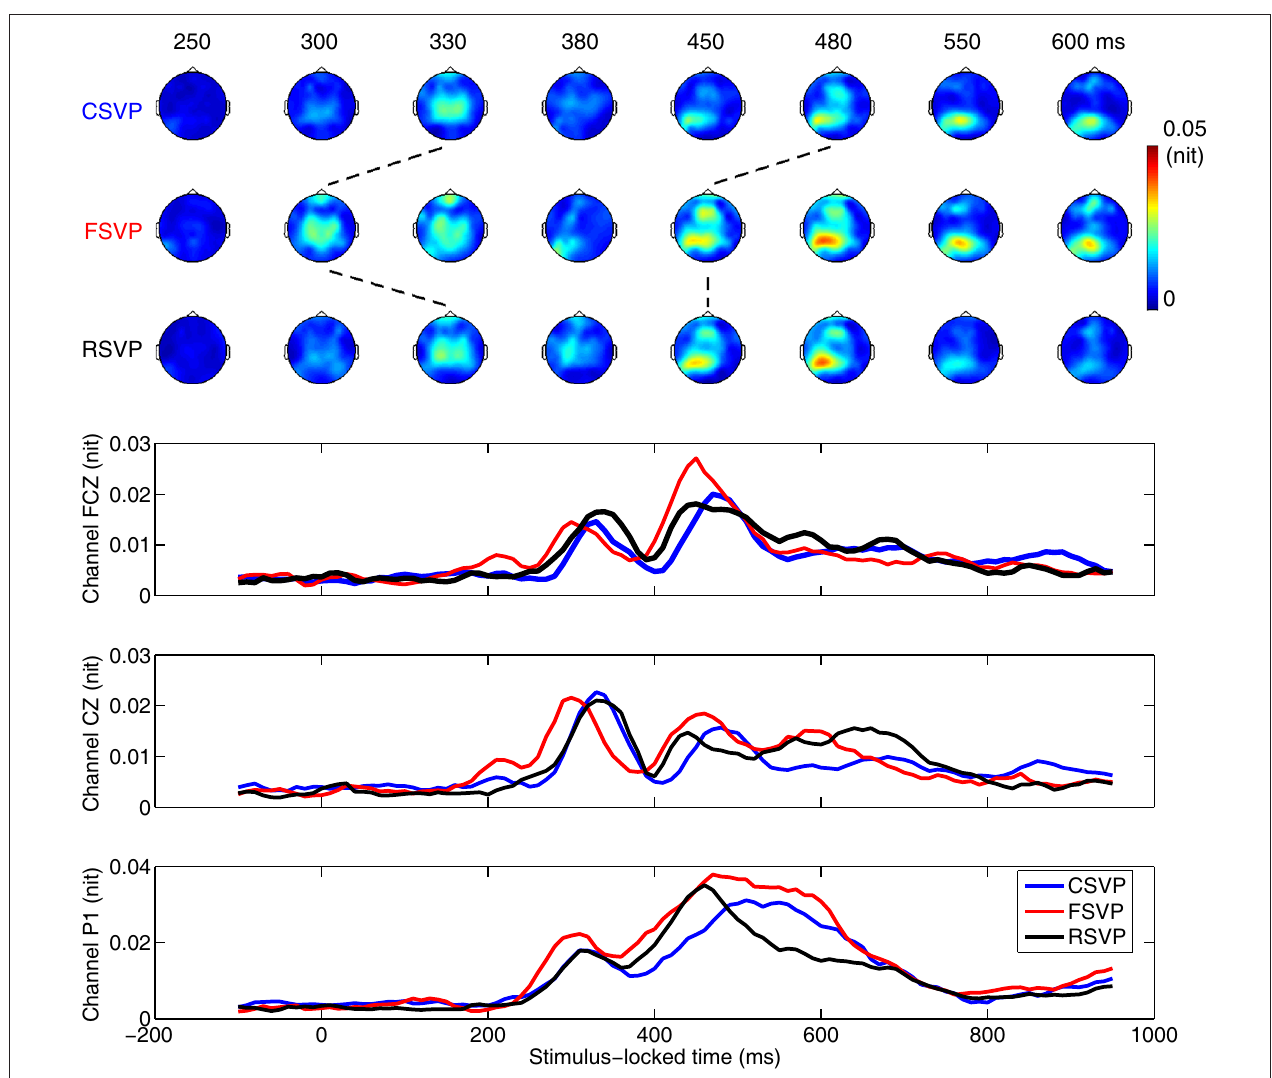
FIGURE 4 | Temporal evolution of the mutual information between the EEG and class label. Top: Scalp plot of the group average mutual information between EEG and the corresponding class labels across subjects. EEG is locked to the trial onset. Dotted lines indicate the time shift in response to different types of stimuli. Bottom: The average mutual information between EEG and the class labels on channels FCZ, CZ, and P1 for Paradigm 1. In all cases the unit of mutual information is the nit (natural log).